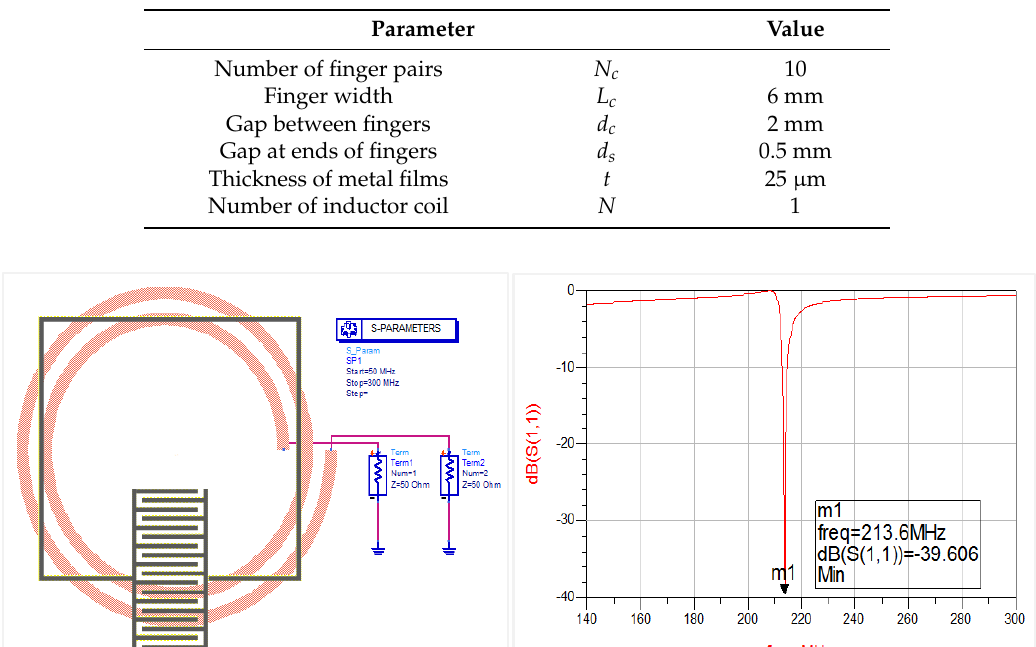
Table 1. Various parameters of sensor.